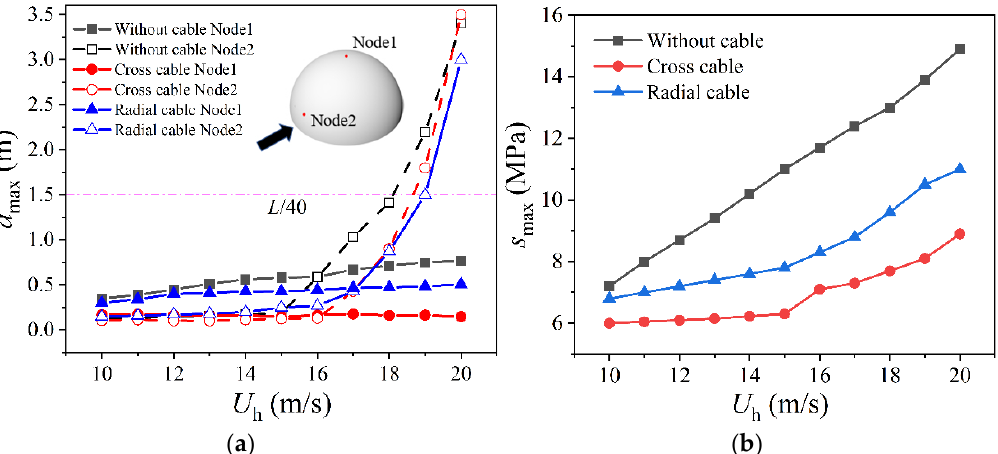
Figure 20. The influence of cables under different wind velocities: ( a ) Displacement; ( b ) Stress.